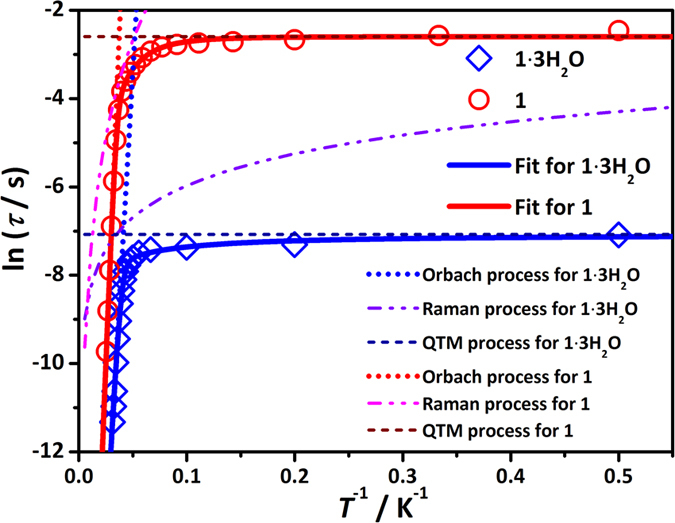
Magnetic relaxation dynamics for [CoII2DyIII].Relaxation behaviors for 1∙3H2O and 1. The solid lines represent the best fits for the relevant compounds.